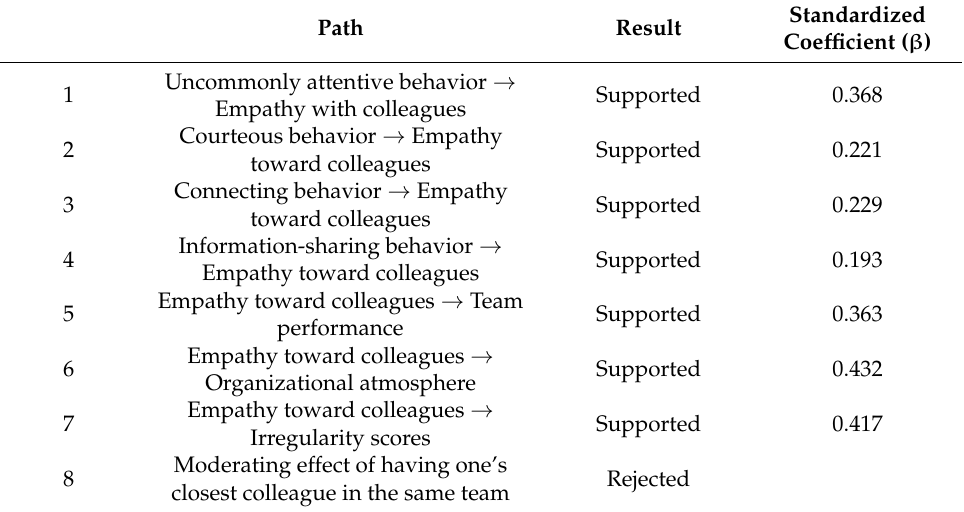
Table 11. Hypothesis